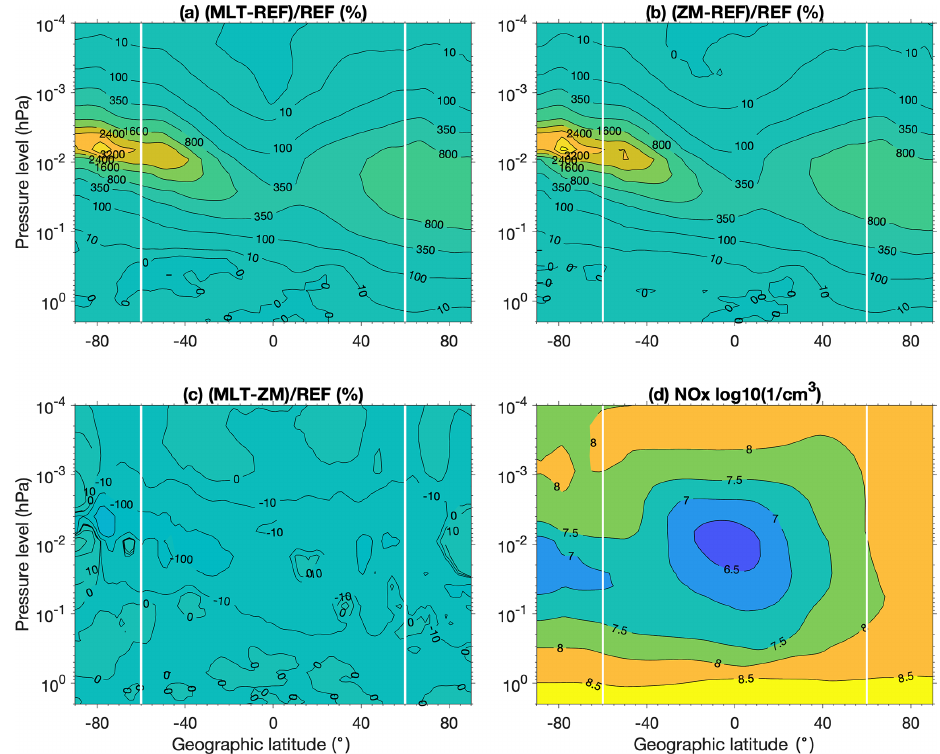
Figure 6. February monthly-mean zonal-mean NO x (=N + NO + NO 2 ) from the extreme-case simulation. Panels (a) – (d) are as in Fig.